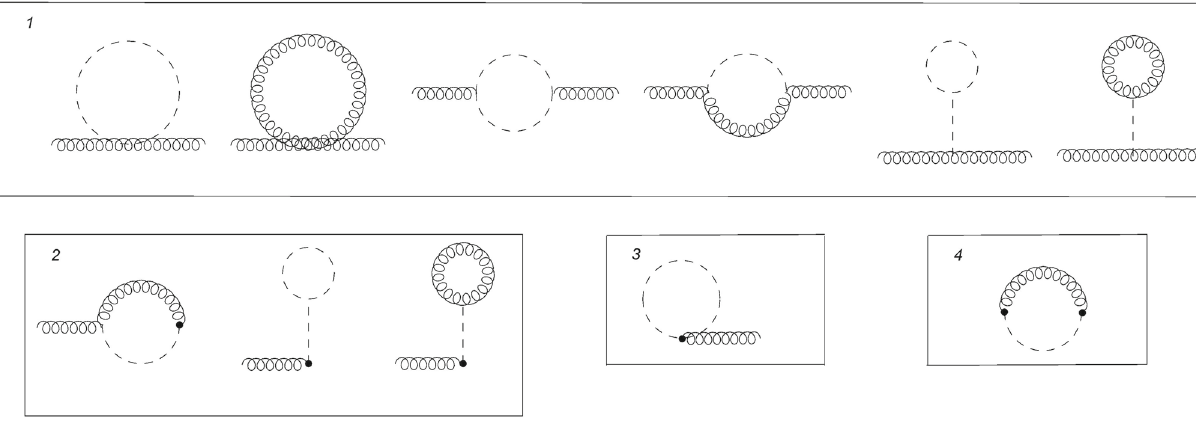
Fig. 15 One-loop contributions for the propagator (cid:2) R a μ ( x ) R a ν ( y ) (cid:3) in the unitary gauge. Curly lines represent the gauge field and dashed lines the Higgs field. The • indicates the insertion of a composite